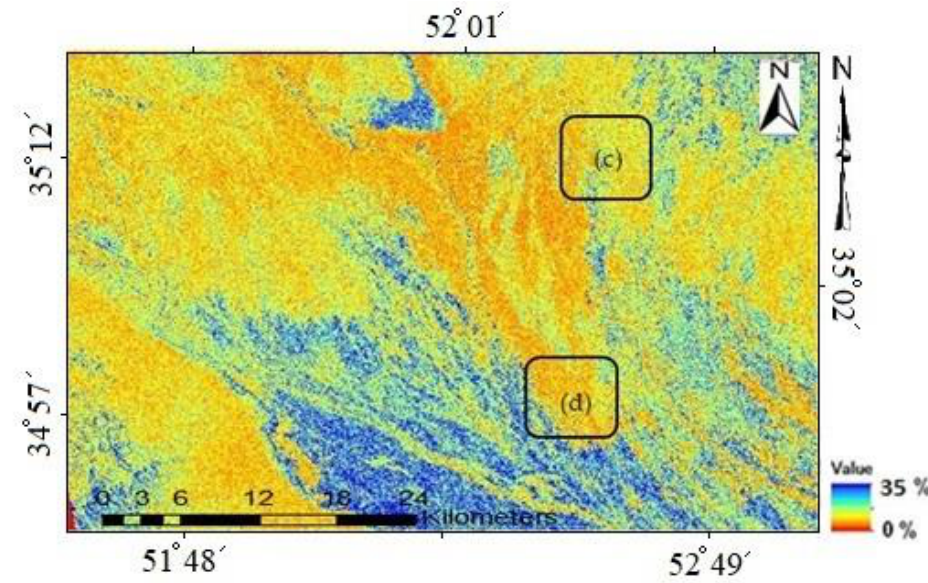
Figure 11. Soil moisture map result of the delta index, and the rectangles (c,d) correspond to the same rectangle placed on the Google Earth image in Figure 9.